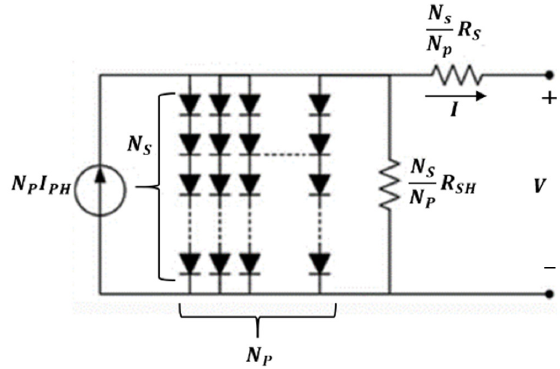
Figure 5. PV array model.